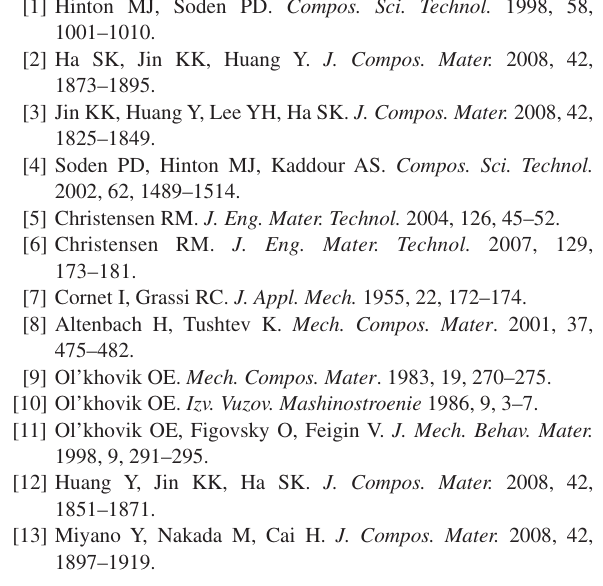
failure stresses for σ eq